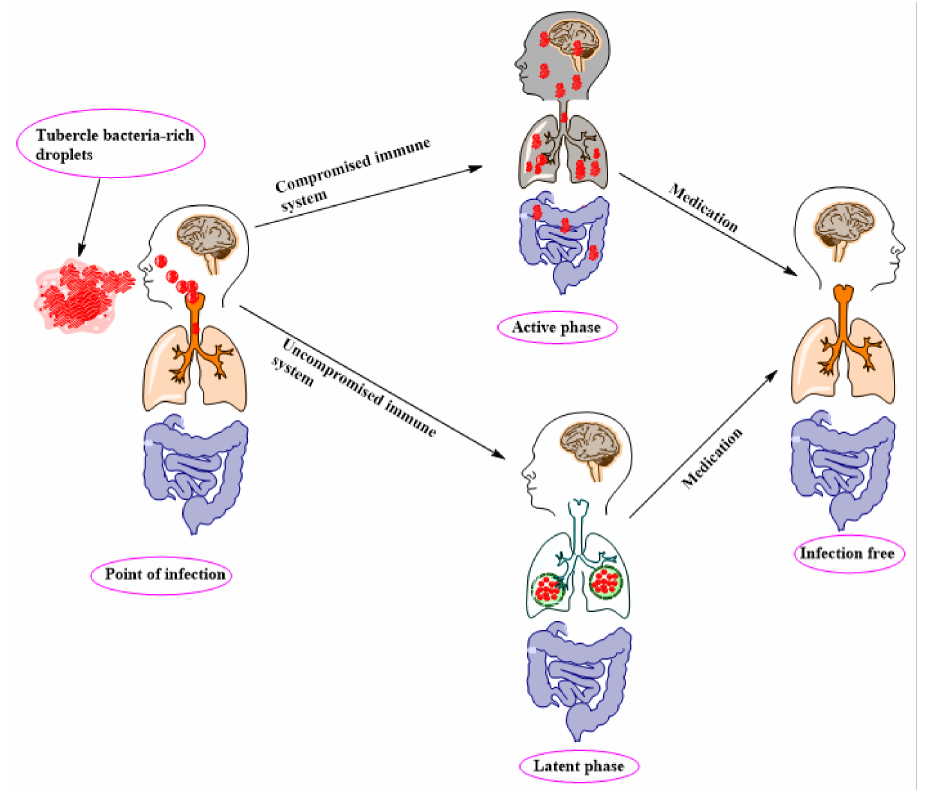
Figure 2. An illustration of tuberculosis (TB) infection